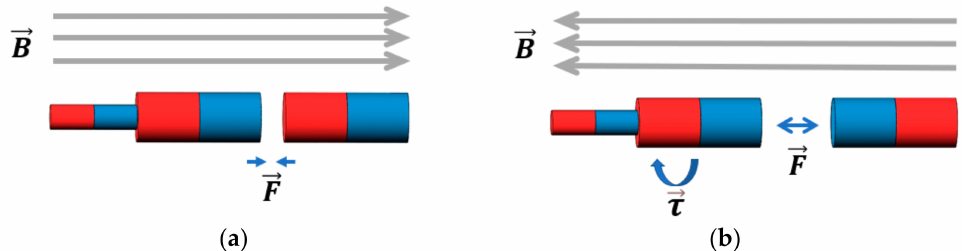
Figure 4. Principles behind the assembly and separation functions. ( a ) Assembly function: when the external magnetic field direction is the same as the magnetization direction of the permanent magnet, an attractive force is generated between modules. ( b ) Separation function: when the external magnetic field is in the opposite direction to the magnetization direction of the permanent magnet, there is a repulsive force between the modules, and torque on the permanent magnet is